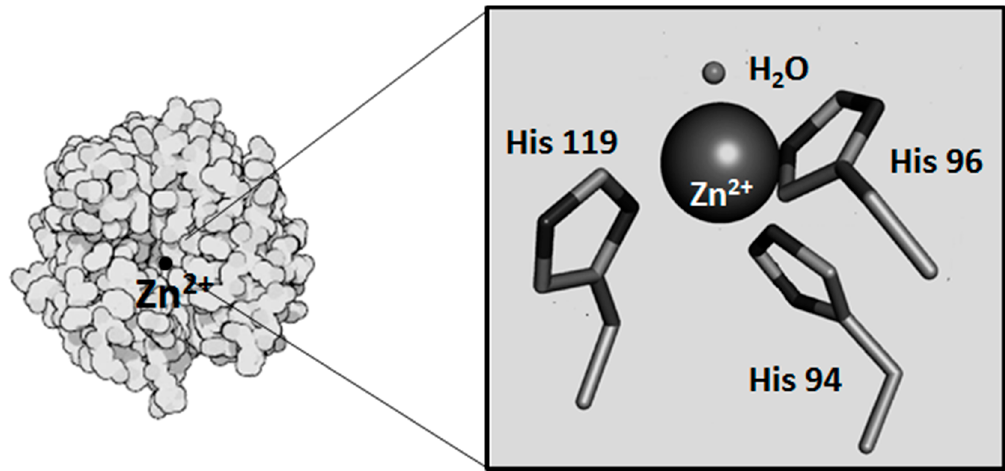
Figure 2. Human CAII: in detail, the metal binding site with the zinc ion as a sphere, the direct ligand histidines, H94, H96, H119, and the water molecule. Modified from Mahon et al [31] and from Dutta and Goodsell [32].